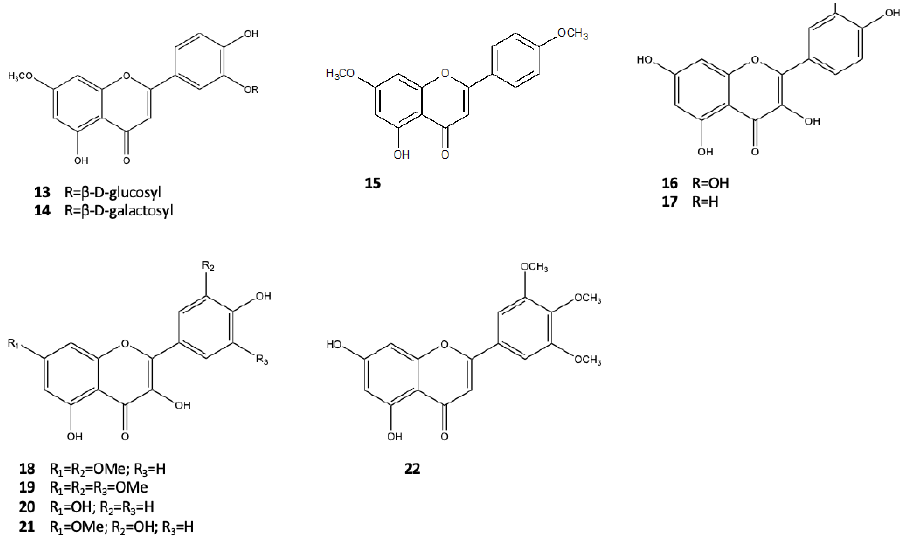
Figure 3. Flavones from A. marina